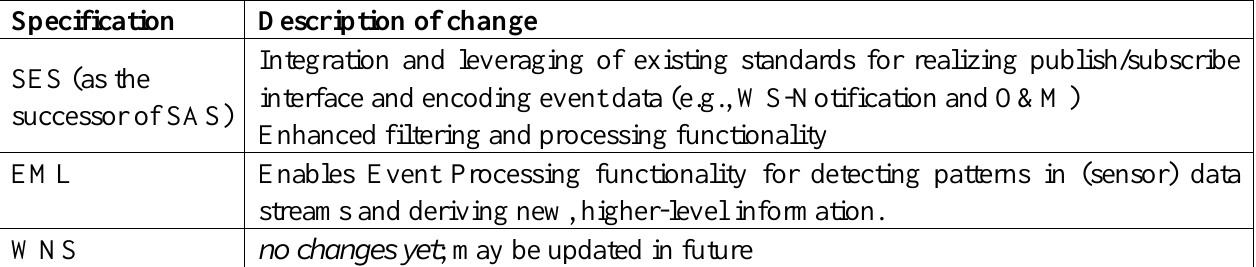
Table 5. Major changes of Eventing and Alerting